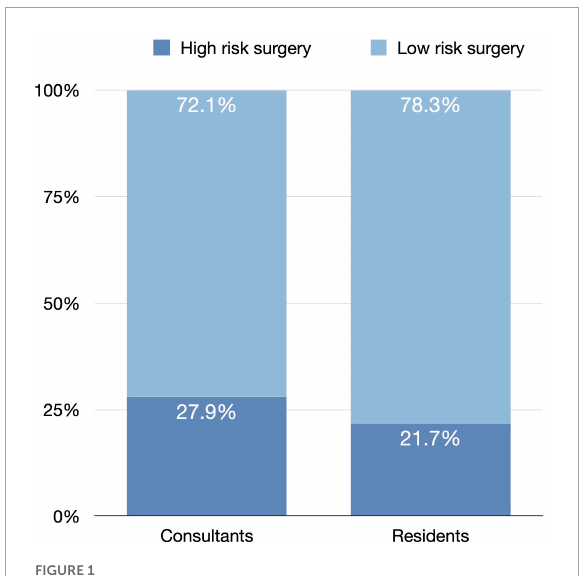
FIGURE1 The frequency of each risk factor studies for cataract surgeries.